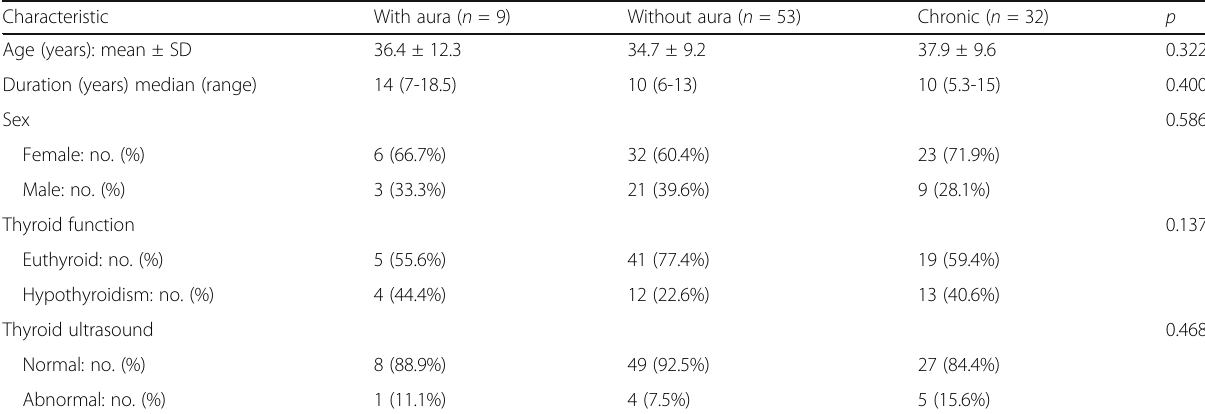
Table 6 Intragroup analysis between migraine subtypes